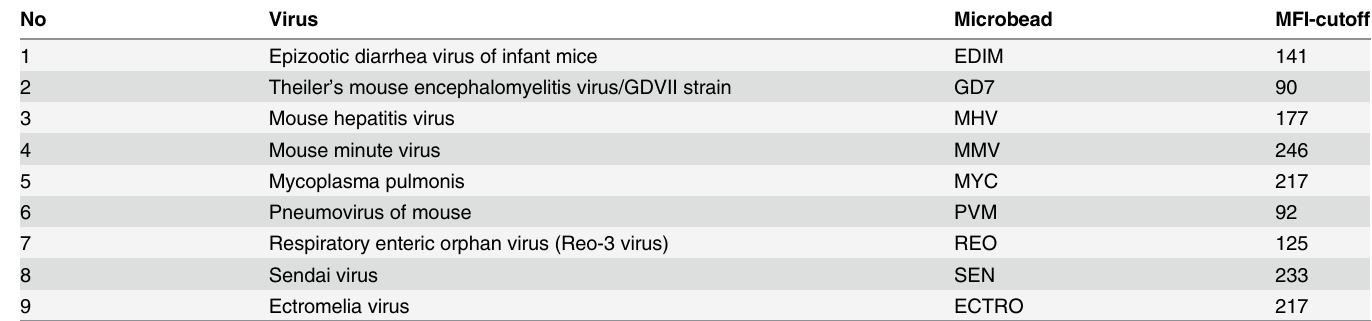
Table 1. Experimentally validated cutoff values of serodetection by